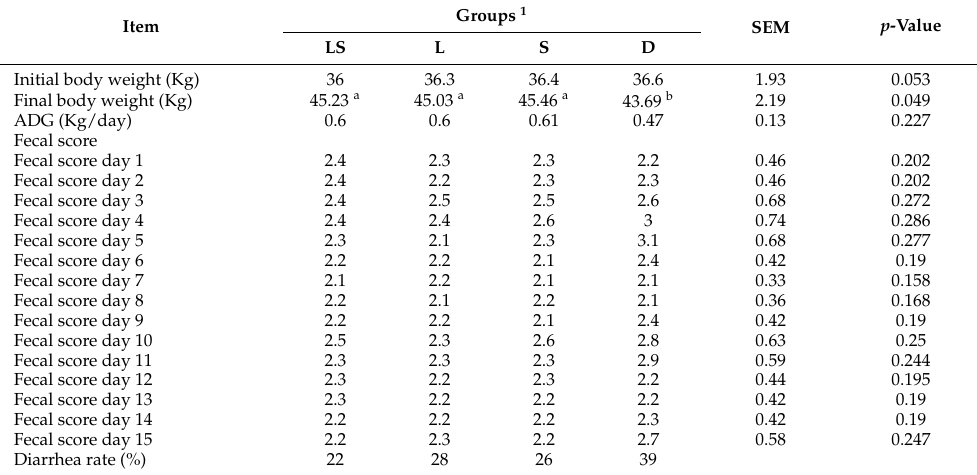
Table 2. Effect of compound probiotics on body weight, average daily gain (ADG), fecal score, and diarrhea rate in newborn calves.